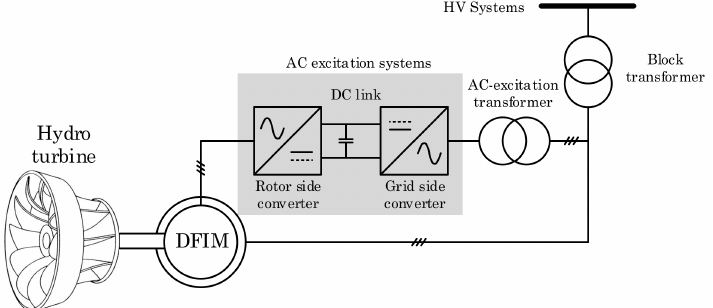
Figure 3. Schematic representation of asynchronous variable speed with doubly fed induction machines (DFIM) technology.